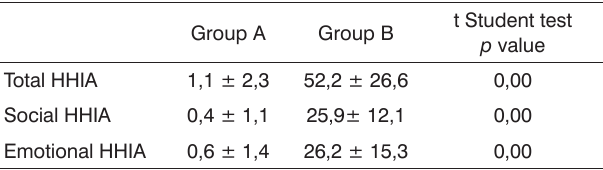
Table 4. Comparison between the mean values and the de- viations of the scores obtained for Group A (n=30) and for Group B